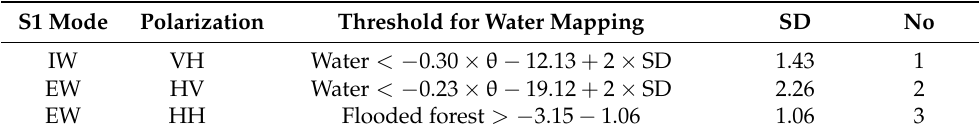
Figure 2. ( a ) Relationship between open-water backscattered signal ( σ 0 ) and incidence angle ( θ ). IW mode data (VH) were acquired from 80 and 58 orbit overflights, and EW mode data (HV) were acquired from 51, 58, 87, 153, and 160 orbit overflights [52]. ( b ) Relationship between flooded forest backscattered signal ( σ 0 ) and incidence angle ( θ ). EW mode data (HH) were acquired from 51, 58, 87, 153, and 160 orbit overflights. Table 5. Water mapping threshold conditions for different polarizations, imaging modes, and flood types (FUV and OWF).